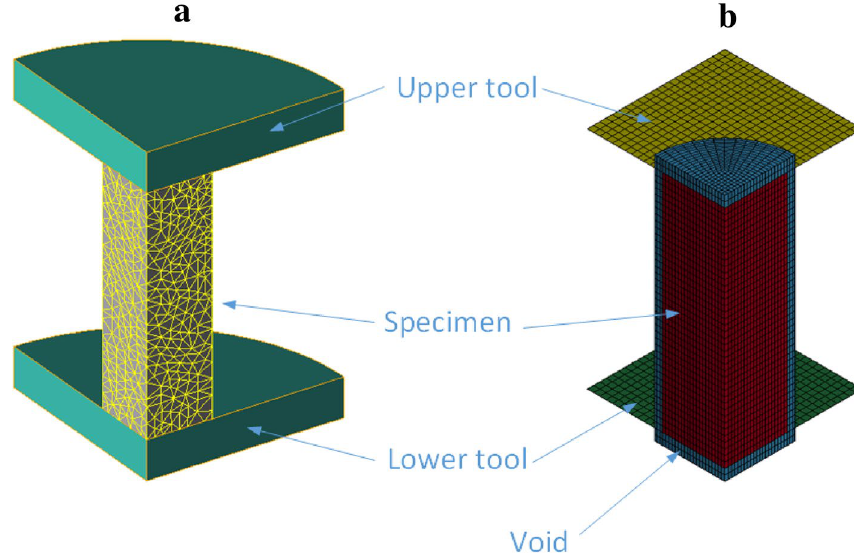
Fig. 4 Finite element models: a QForm and b